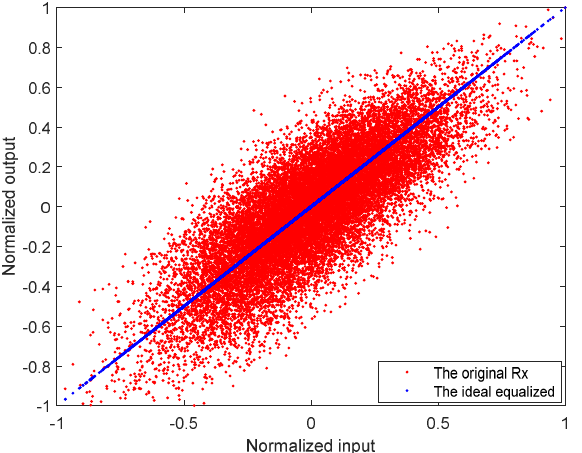
Figure 2. The memory effect of the channel impairments involving in the received signal.